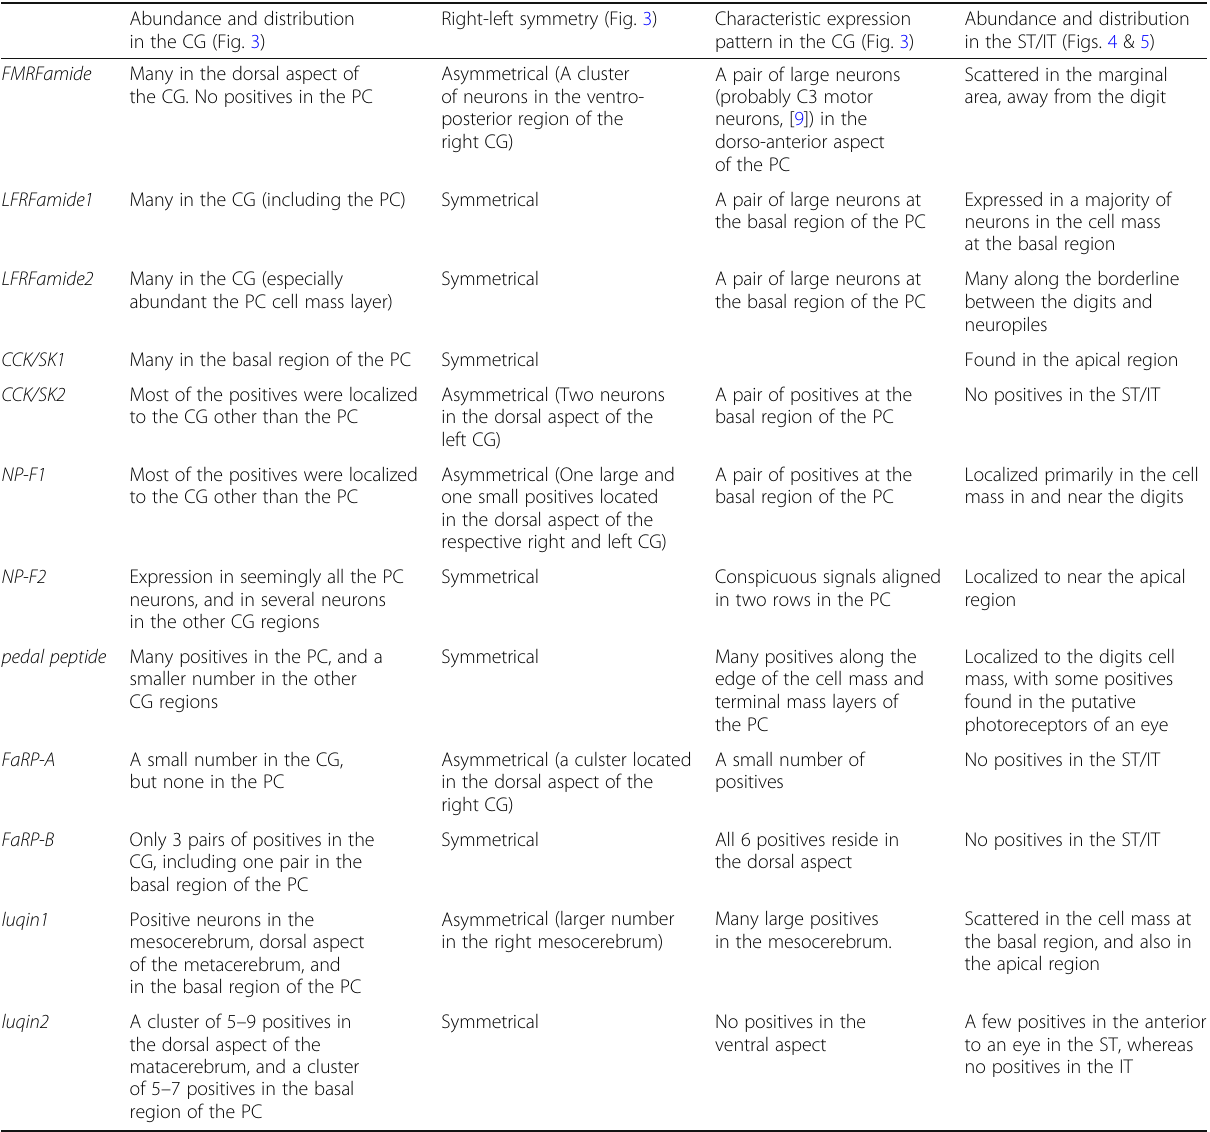
Right-left symmetry (Fig. 3) Characteristic expression